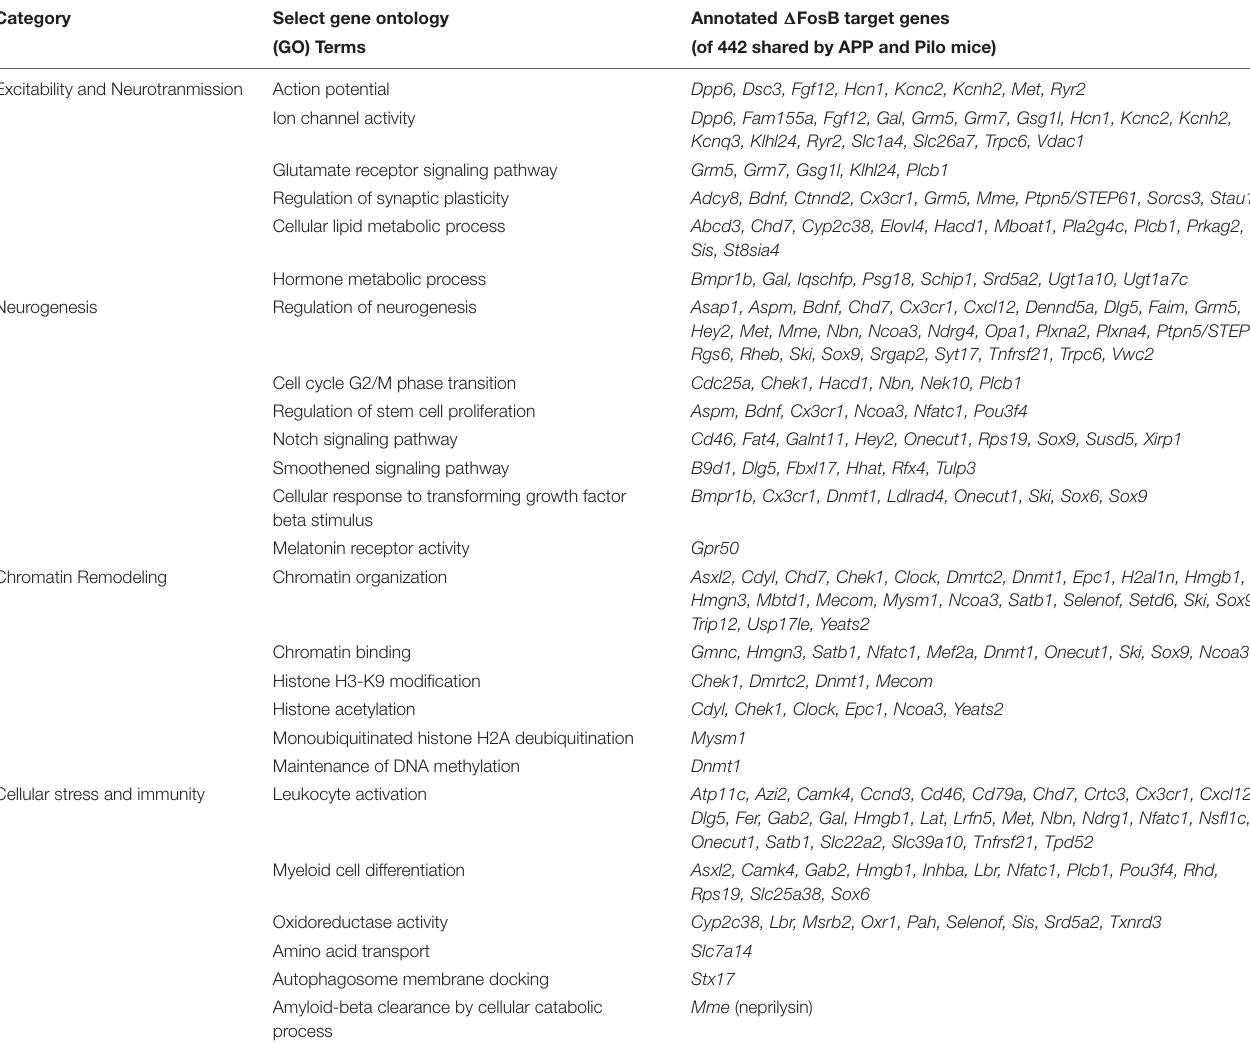
TABLE 1 | (cid:49) FosB target genes bound in APP and Pilo mice are associated with GO Biological Processes that may influence AD and other diseases with recurrent seizures. Category Select gene ontology